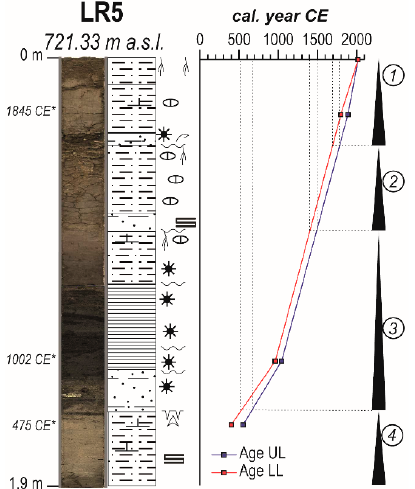
Figure 4. Age model for core LR5. Same key as for Figure 3. UL: upper age limit; LL: lower age limit.